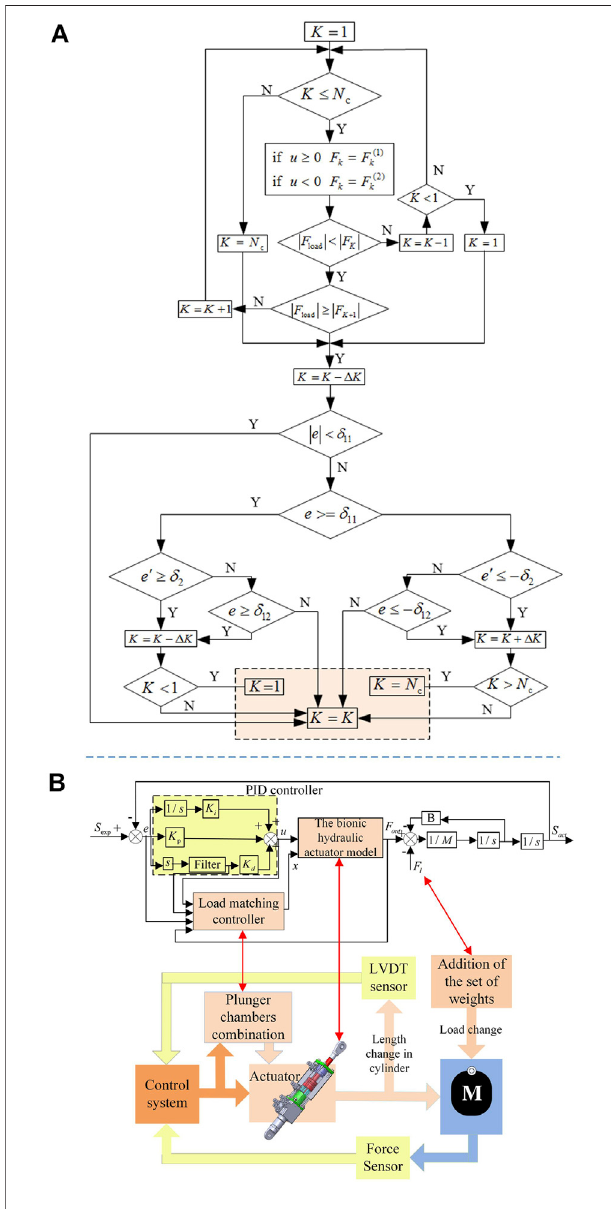
FIGURE 5 | The BHA control system (A) . Load matching control process; (B) . The bionic hydraulic actuator control